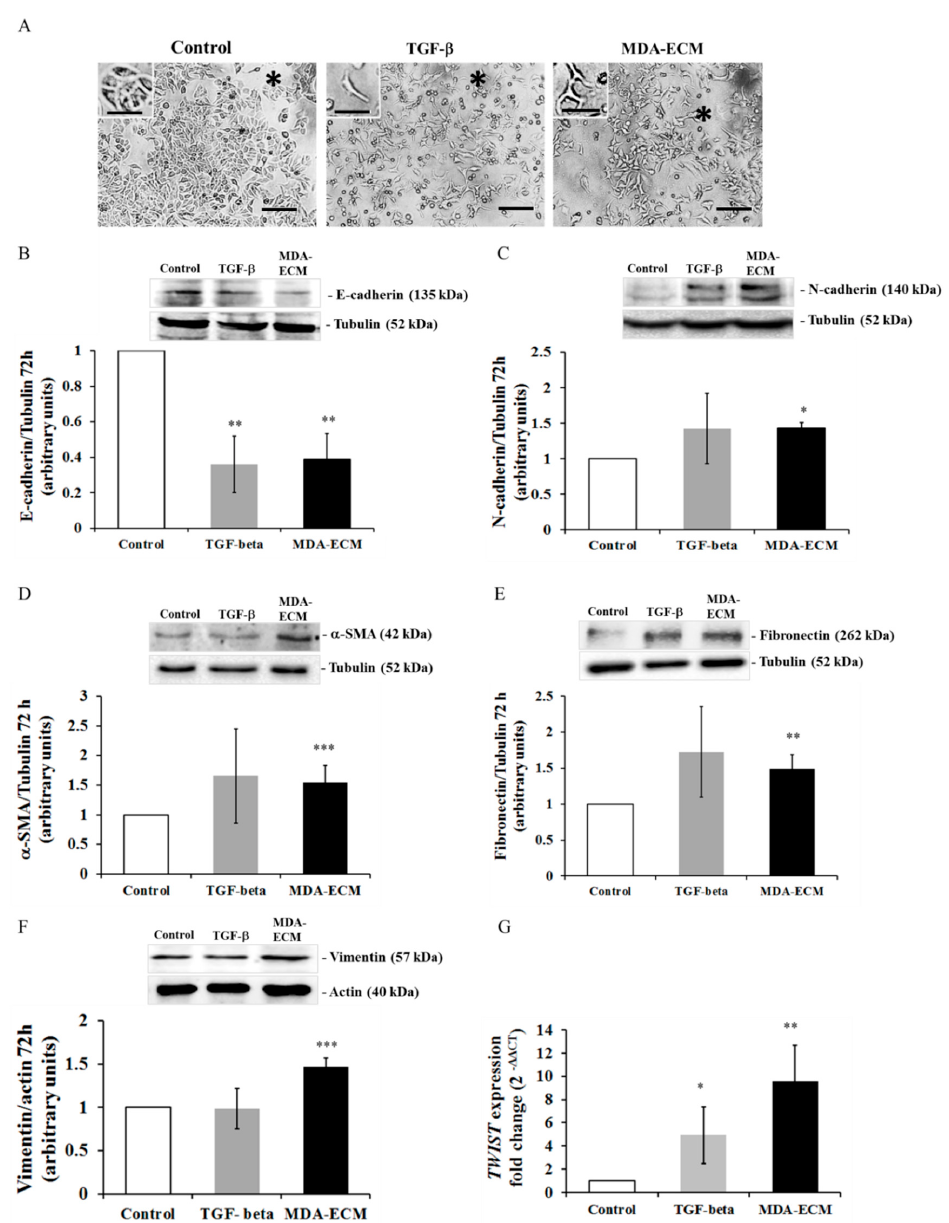
Figure 3. MDA-MB-231-derived ECM triggered morphological and phenotypical changes related to epithelial-mesenchymal transition (EMT) in MCF-7 cells after 72 h. MCF-7 and MDA-MB-231 cells were cultured in standard conditions for 72 h, and decellularized ECMs were obtained, as described in Methods. MCF-7 cells were cultured onto MDA-ECM or onto their own matrix with TGF- β 1 (10 ng / mL) for 72 h. ( A ) Cell morphology was analyzed, and representative images were obtained at 40 × magnification. A black asterisk indicates lost or remaining intercellular connections. Scale bar: 20 µ m ( B – F ) Lysates of MCF-7 cultured as described for 72 h were immunoblotted with anti-E-cadherin ( B ), anti-N-cadherin ( C ), anti- α -SMA ( D ), anti-fibronectin ( E ), and anti-vimentin ( F ) antibodies. The results are shown as the mean fold increase relative to the control (MCF-ECM), and bars show the mean ± SD calculated from 3 individual experiments (* p < 0.05, ** p < 0.01 and *** p < 0.001). ( G ) MCF-7 cells were cultured for 48 h on MCF-ECM with or without TGF- β 1 or MDA-ECM, and the expression of TWIST mRNA was analyzed. β -Actin was used as a housekeeping gene. The results are shown as the mean ± SD calculated from 3 individual experiments (* p <